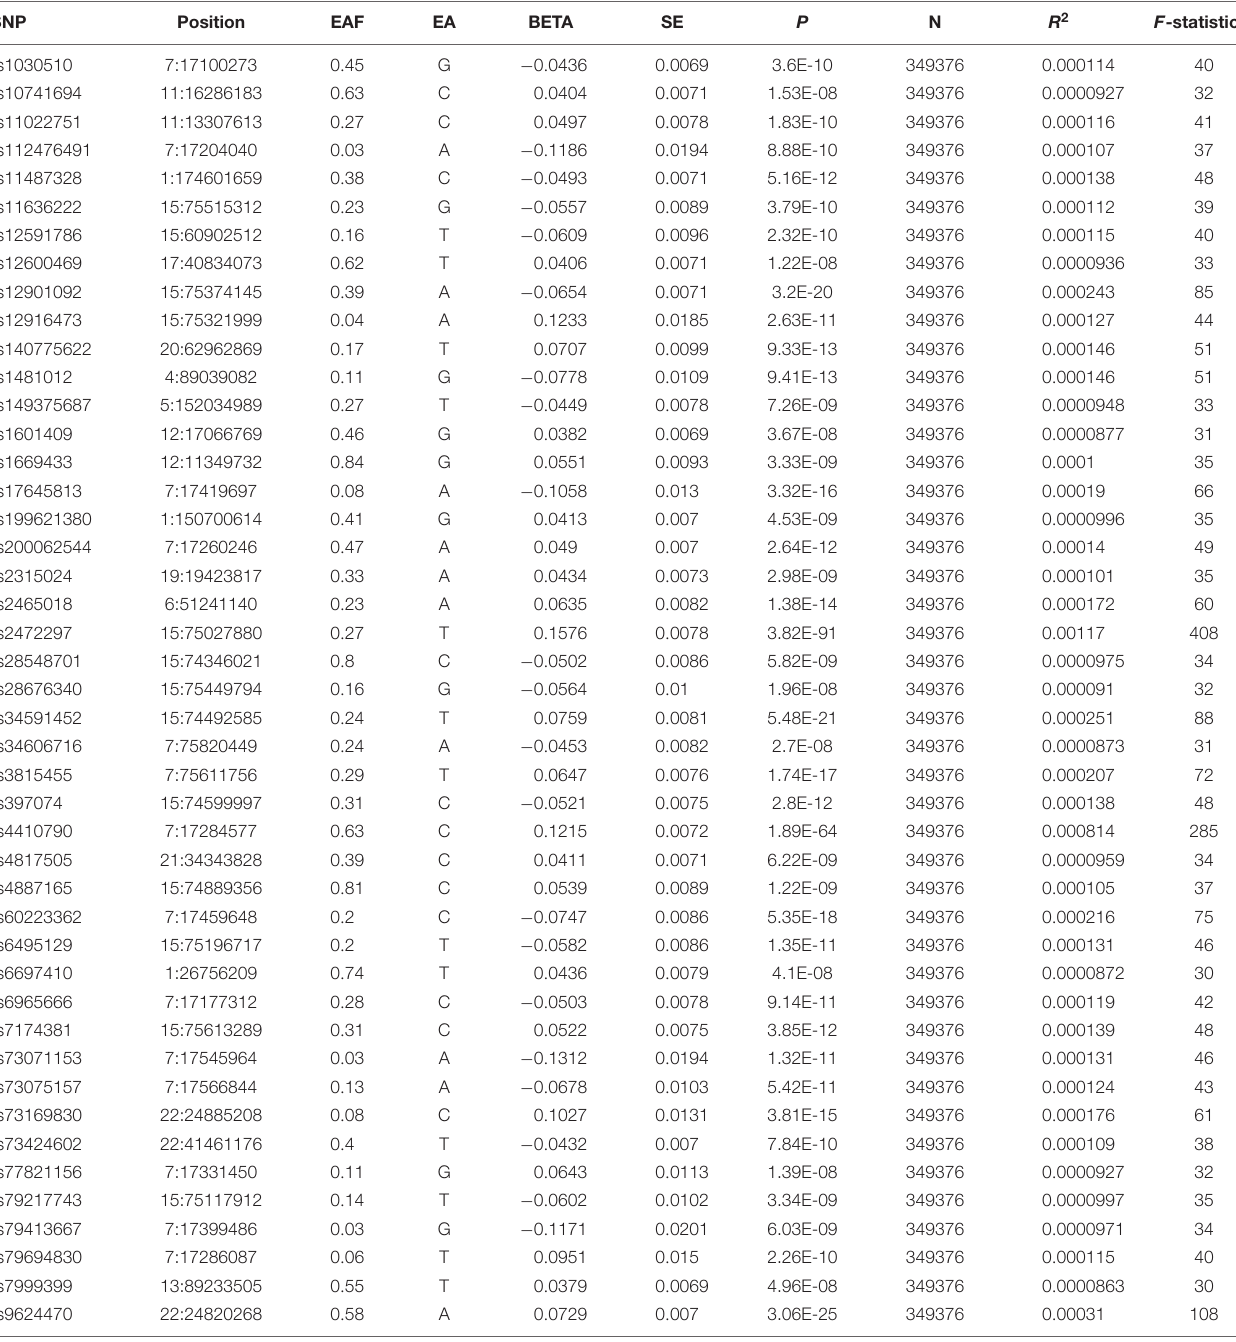
TABLE 1 | Characteristics of SNPs associated with tea